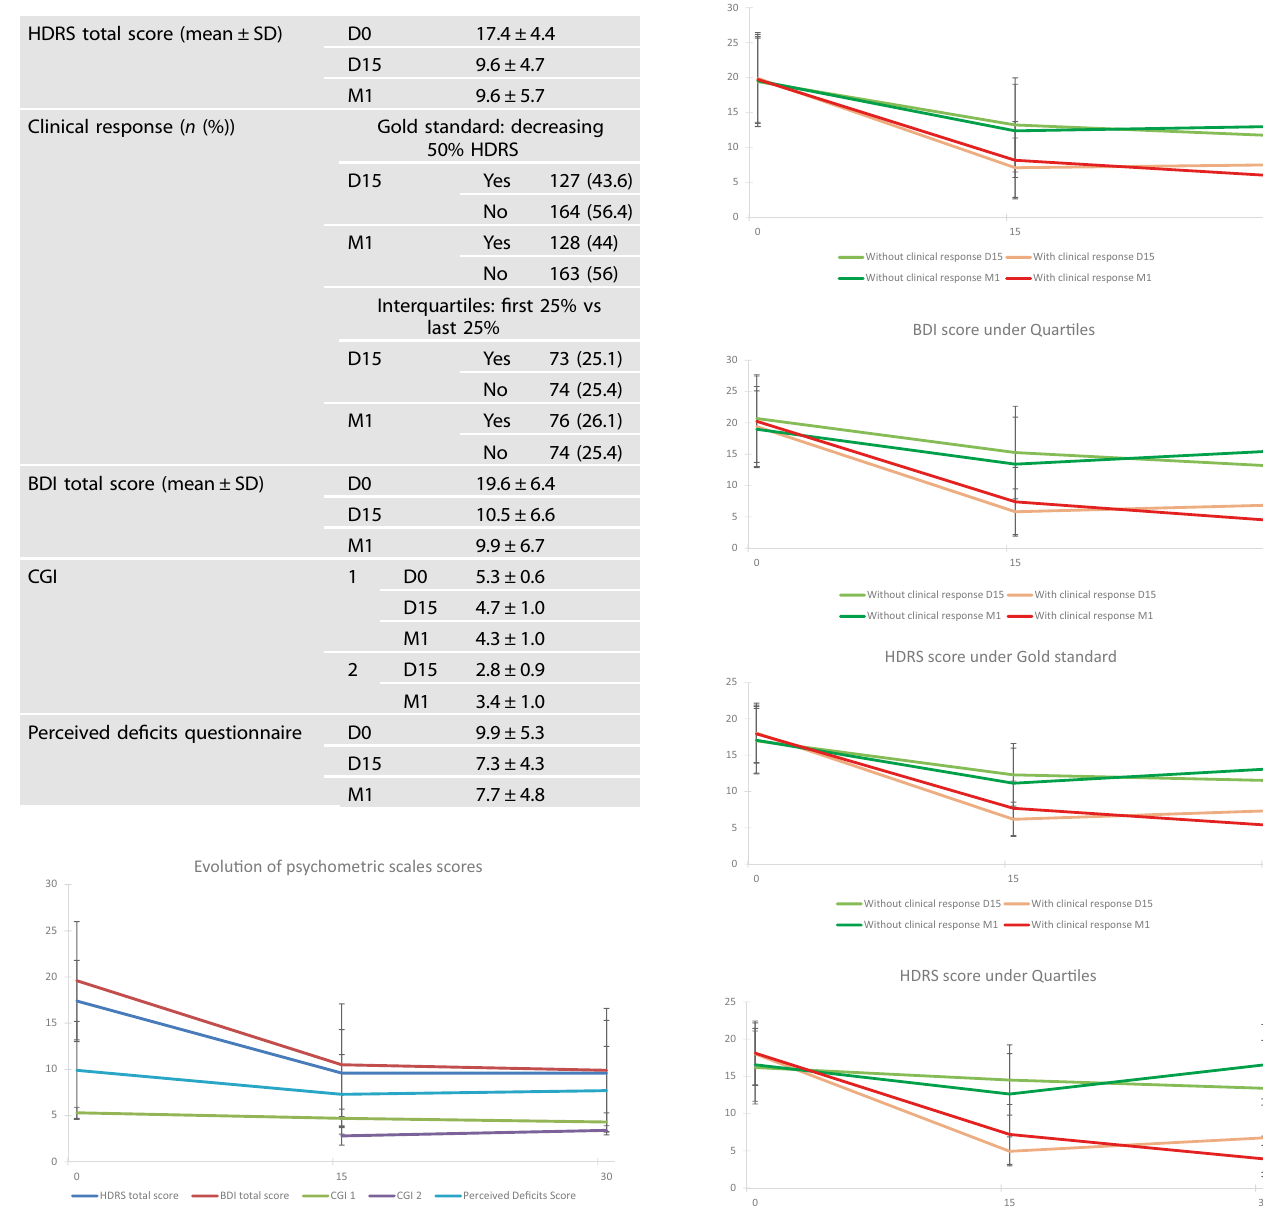
Table 2. Evolution of scores from D0 to M1.